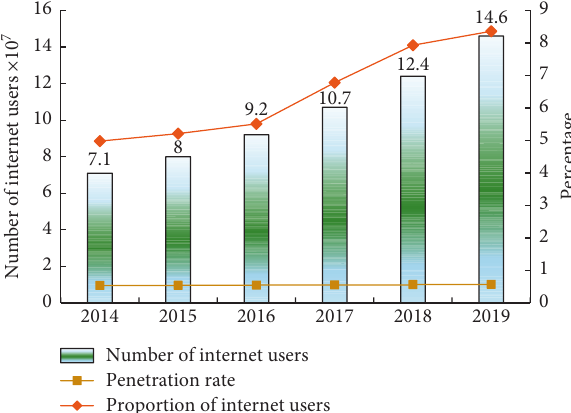
Figure 2: Number and penetration rate of Internet access for the elderly from 2014 to